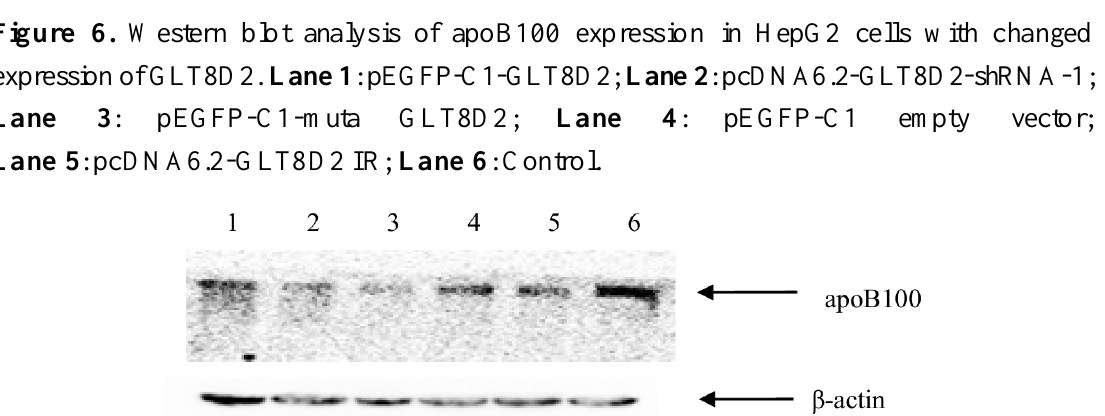
Figure 6. Western blot analysis of apoB100 expression in HepG2 cells with